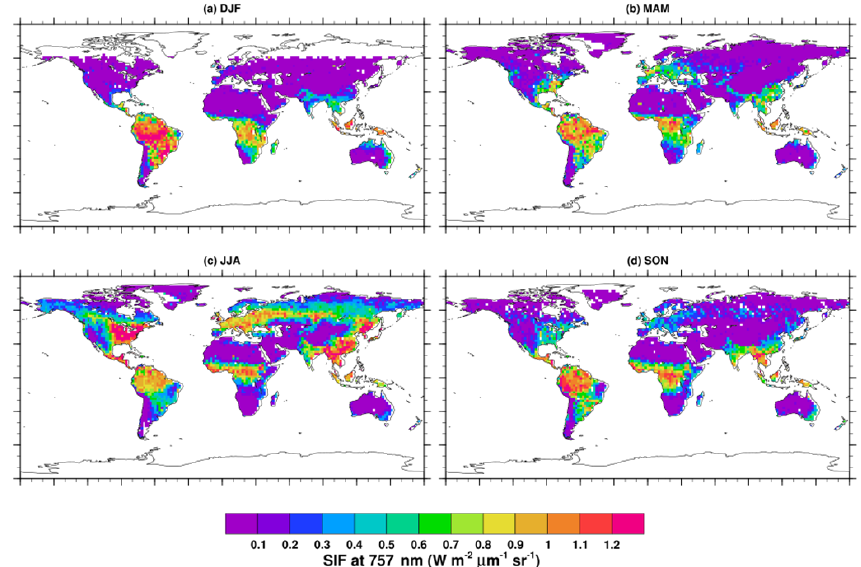
Figure 11. OCO-2 solar-induced fluorescence (SIF) product averaged on 2 ◦ by 2 ◦ grid for 3-month periods (December 2014 through November